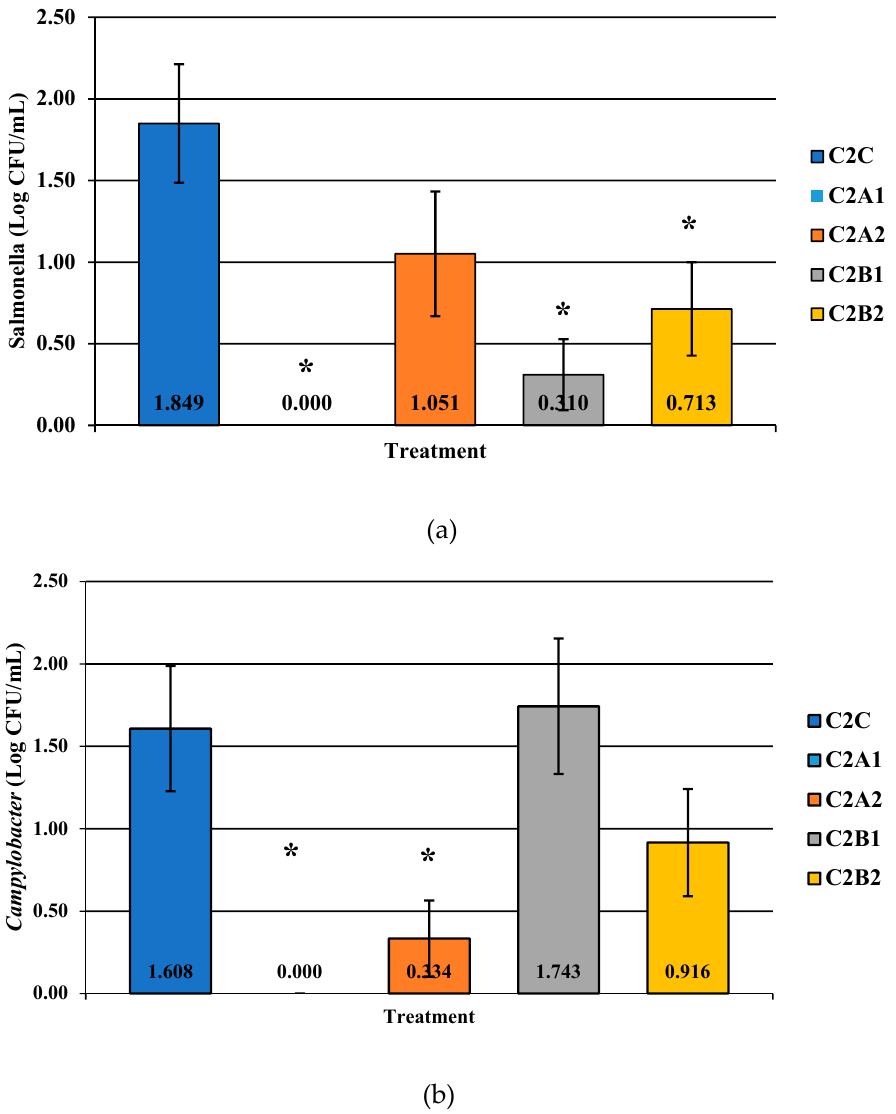
Figure 6. The effect of Competitor 2, a PAA sanitizer used as an antimicrobial dip (400 or 600 ppm) and in a stationary chilling tank (25 or 45 ppm) on the load of Salmonella ( a ), total aerobic bacteria ( b ),